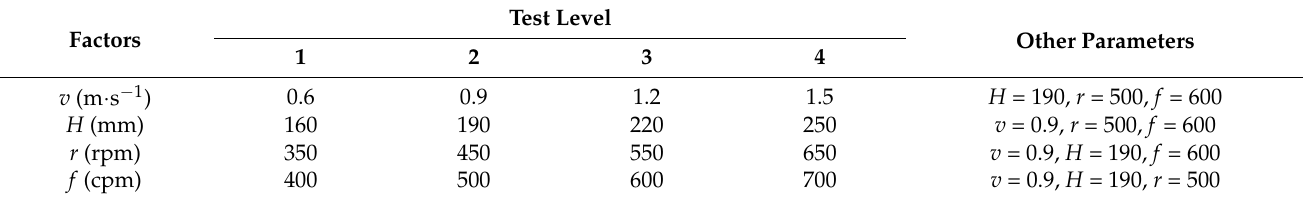
Table 1. Experimental factors and their